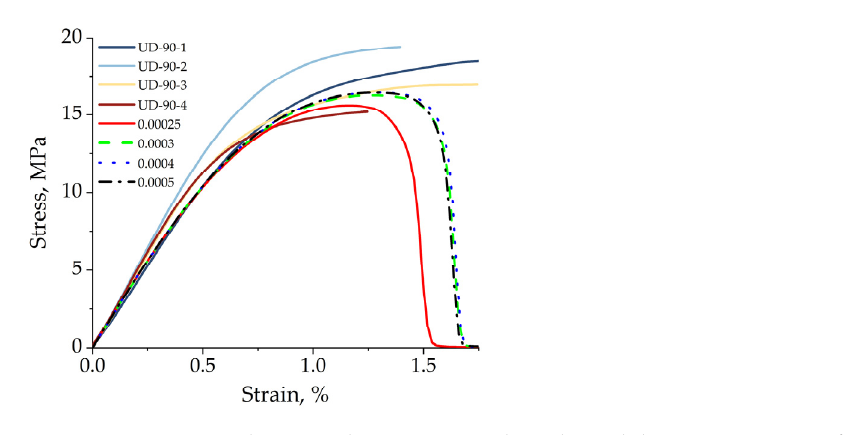
Figure 9. Comparison between the experimental results and the RVE-3 response for characteristic element length in the range from 2.5 × 10 − 4 to 5 × 10 − 4 .